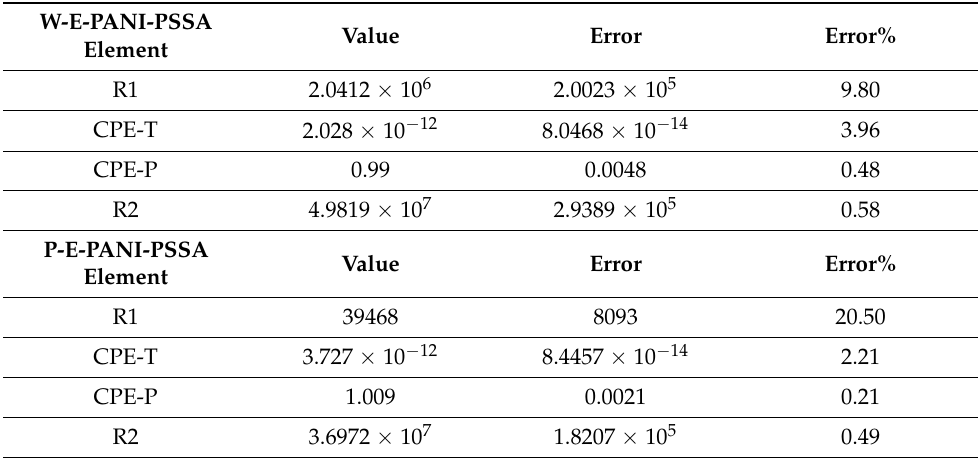
Table 3. Circuit elements and errors for coated textiles obtained by emulsion